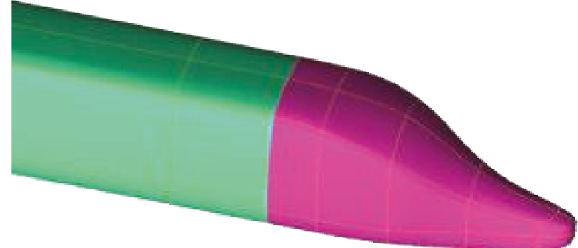
Figure 5: Bionic head type of high-speed trains based on